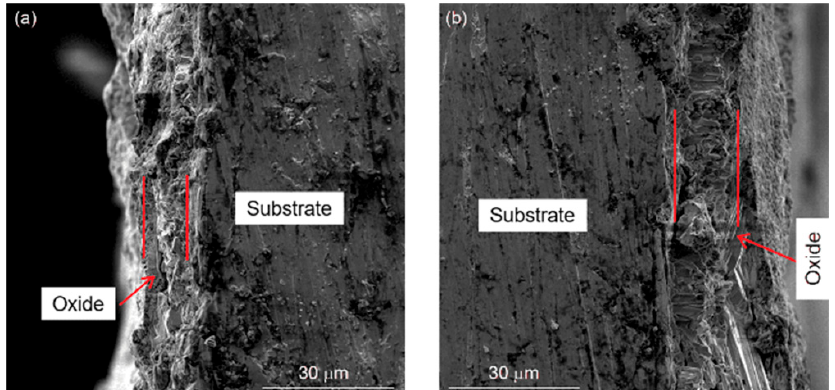
Figure 11. The three-point bending experiment results during the oxidation of MoCu alloy at 55 °C [95]; ( a ) oxide film at the compressive region; ( b ) oxide film at the tensile region.